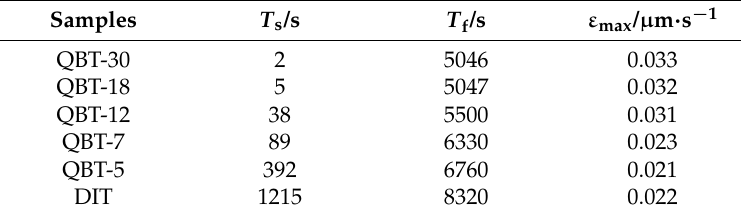
Figure 2. Comparison of bainite transformation kinetics between DIT and QBT samples during isothermal treatment at 300 °C. ( a ) Dilatation–time curves; ( b ) transformation rate curves. Table 1. Bainite transformation time and maximum transformation rate.